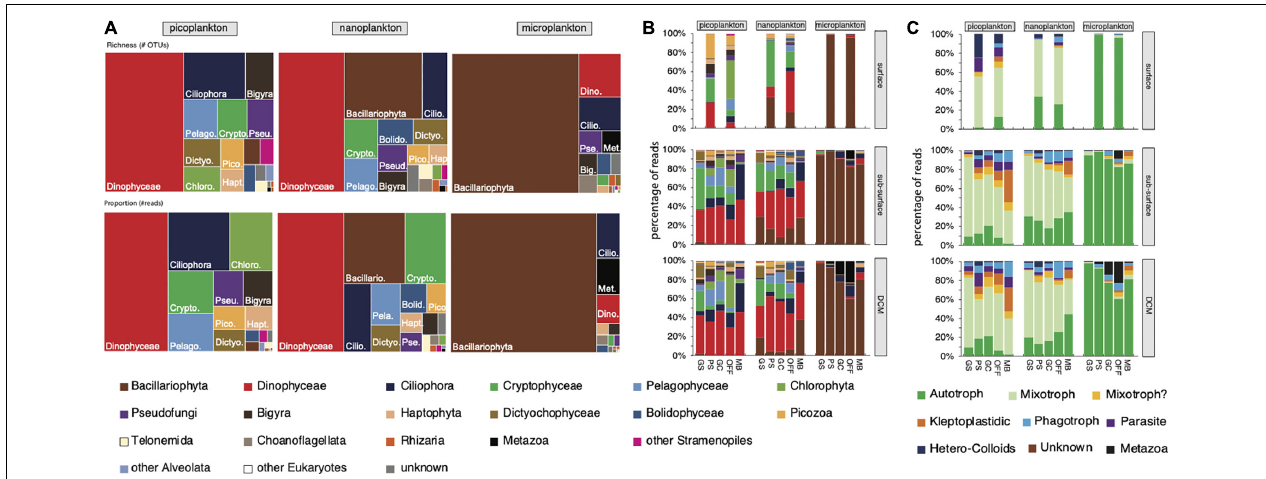
FIGURE 2 | Distribution of (A) lineages per size fraction, and (B) lineages and (C) trophic mode by size fraction, depth and group, showing the distinct composition of micro-, nano-, and picoplankton and the pattern related to the geographical location. Surface and sub-surface samples showed a different distribution, while subsurface and DCM samples shared a more comparable composition. (B,C) Bar graphs used the abundant OTUs, while (A) the treemap graph used all P-E